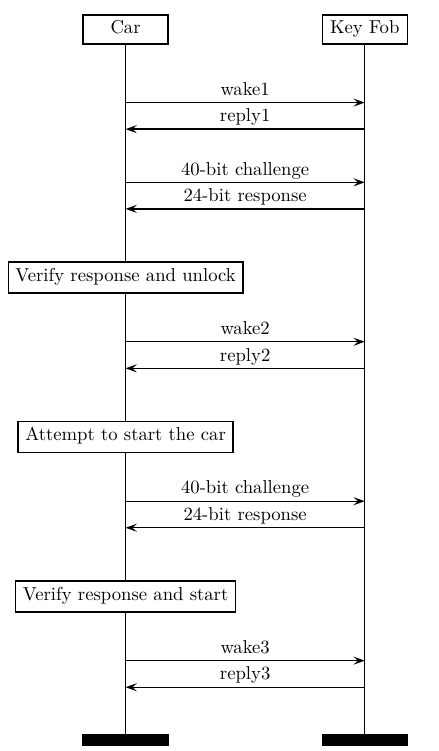
Figure 4: The PKES protocol during nominal operation assuming the key fob is in range of the car.